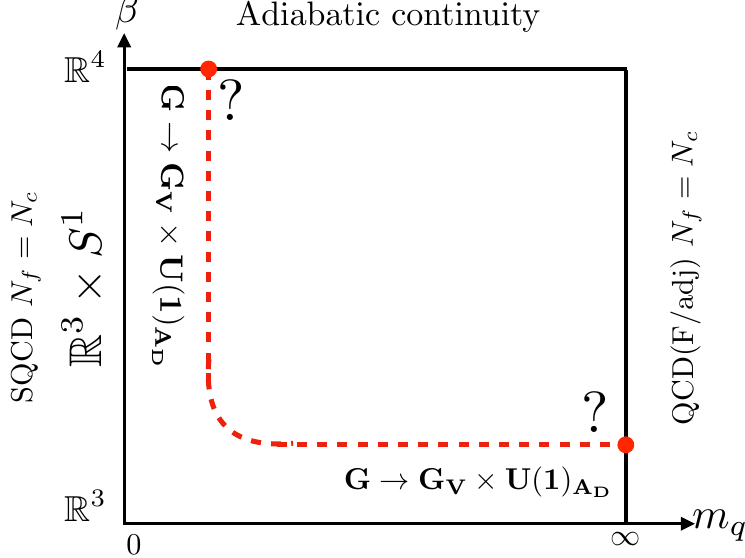
Figure 11 . There exists an adiabatic continuity between N f = N c SQCD and its soft super- symmetry breaking scalar mass deformation m at strong coupling on large S 1 × R 3 and non- q a supersymmetric QCD(F/adj) at weak coupling on small S 1 × R 3 . There is very likely a phase transition associated with U(1) crossing red-dotted line, but absence of phase transition is also A D consistent with mixed